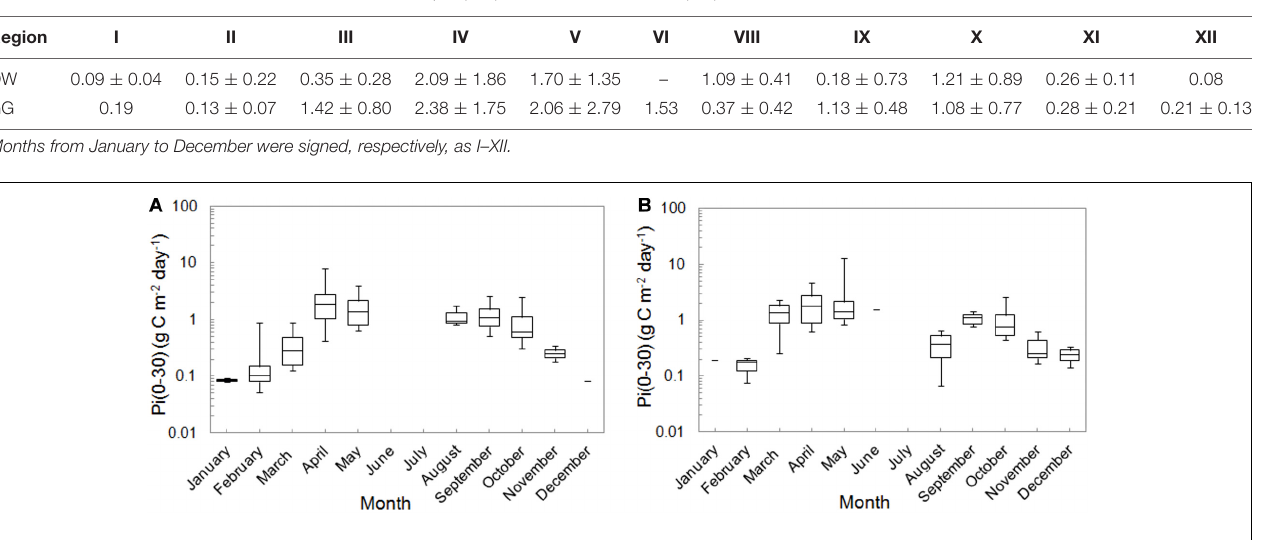
The main reasons of the discrepancies are the measurement details, in particular the used filters. According to